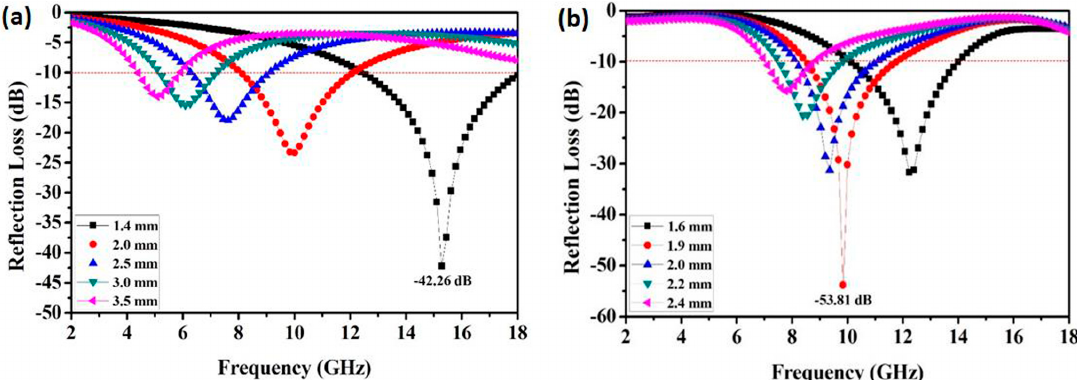
Figure 5. Reflection loss (RL) value of FeCo single-phase solid solution ( a ) and FeCo / ZnO composite ( b ).